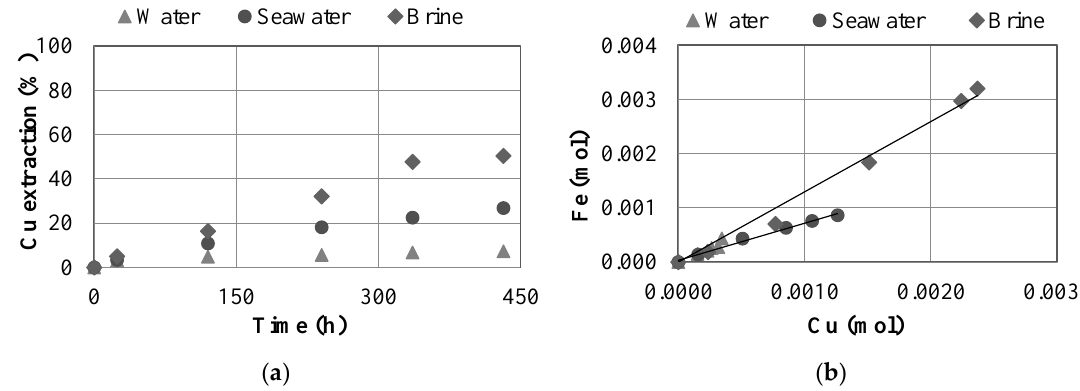
Figure 3. ( a ) Copper extraction (%) versus time (h) when different dissolvent were used: distilled water (water), seawater, and brine. ( b ) Cu/Fe molar ratio when different dissolvent were used: distilled water (water), seawater, and brine. Experimental conditions: [NaNO 3 ] = 0.7 M, [H 2 SO 4 ] = 0.7 M, −150 + 75 µm, S/L ratio 2 g/L, 45 °C, 350 rpm, sample A.